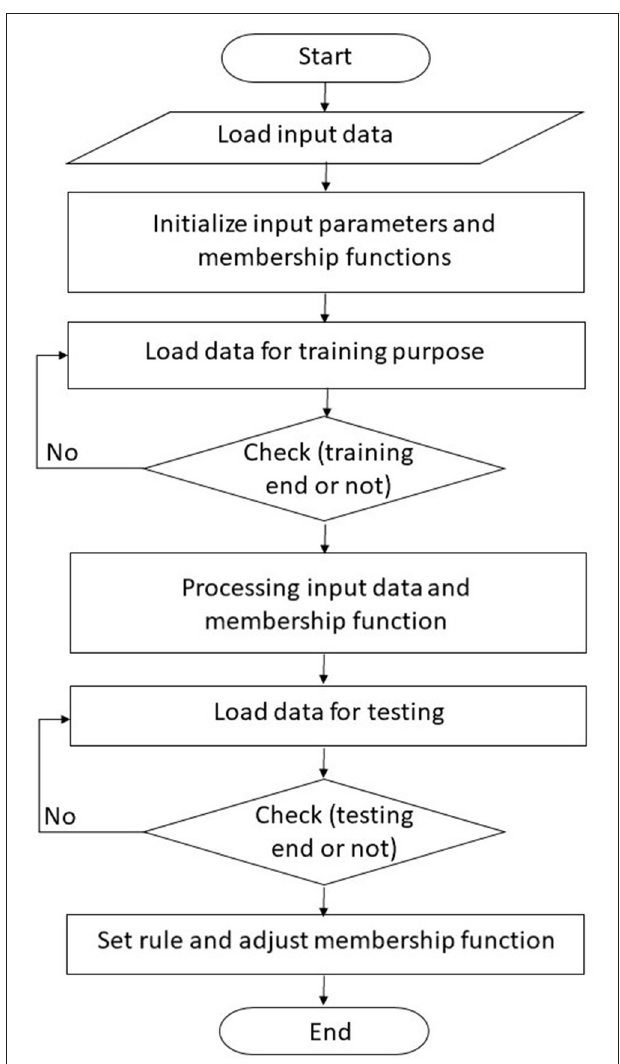
FIGURE 3 | Flow chart of ANFIS-based system.